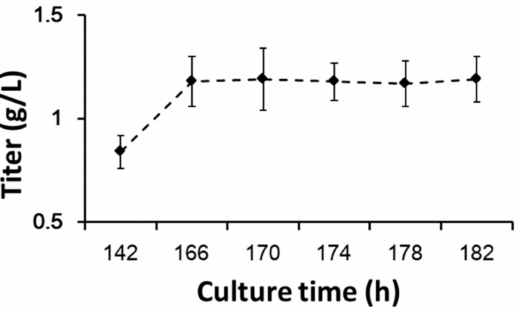
Figure 7. Protein yields with prolonged glucose withdrawal. Data are expressed as mean ± standard error of three